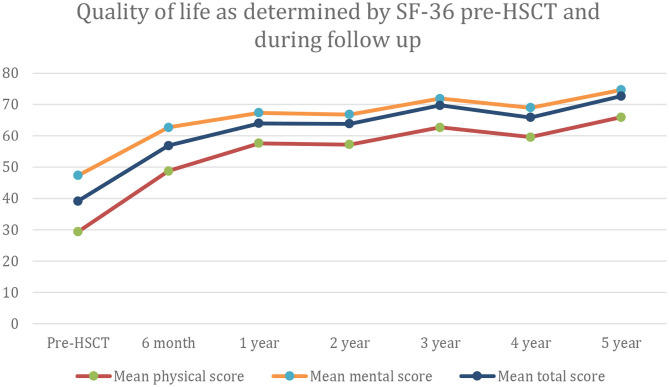
Quality of life as measured by the SF-36 rating scale at baseline and for up to 5 years after hematopoietic stem cell transplantation (HCST).